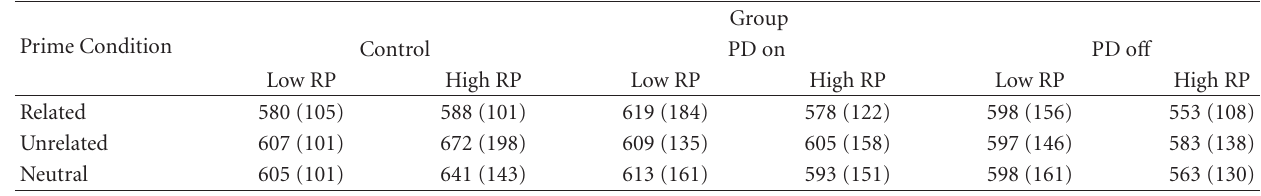
Table 1: Mean RTs in milliseconds for the control group and the PD group “on” and “o ff ” medication as a function of RP and prime